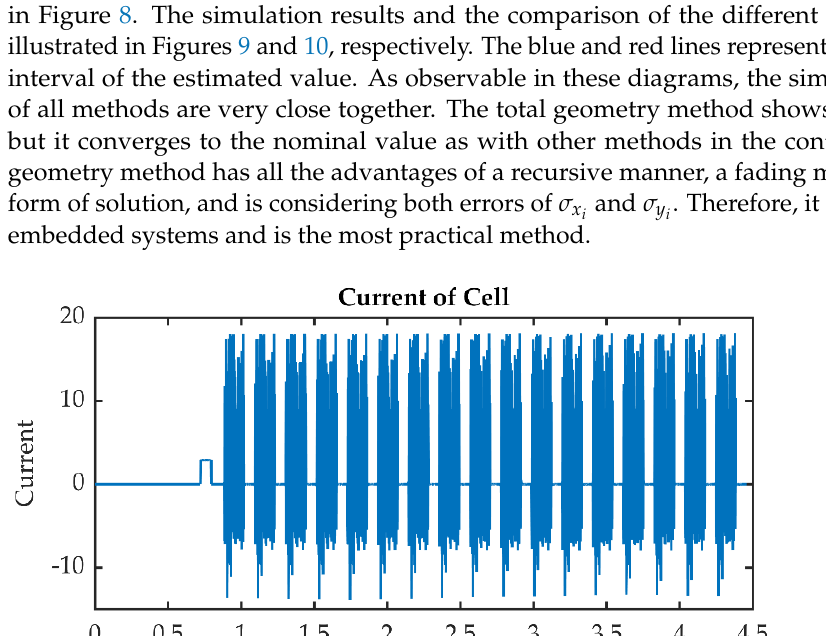
Figure 6. Battery voltage characteristic. Figure 7. Unfiltered and filtered Re .